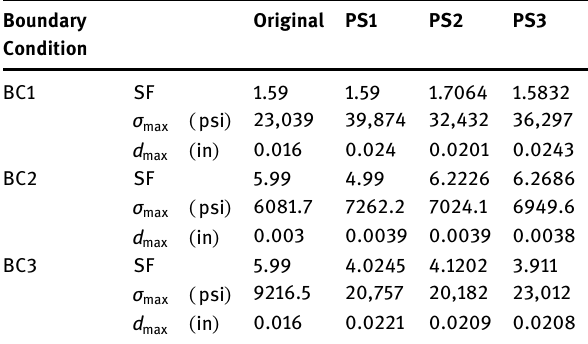
Table 5: Summary of numerical validation study results ( SF - safety factor )